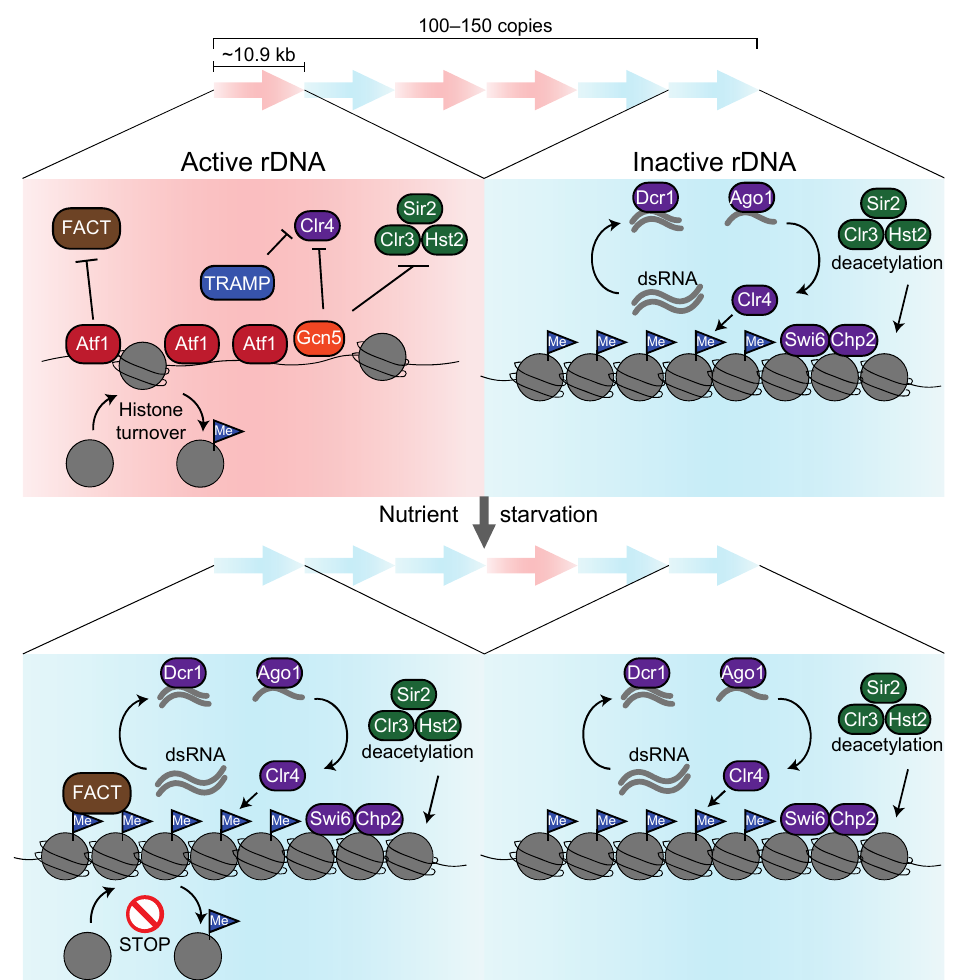
Figure 6. Regulatory mechanisms of rDNA gene expression in S. pombe . In nutrient-rich conditions (the pink area on the left), transcription factor Atf1 prevents the accumulation of histone chaperone FACT. Gcn5 HAT competes with histone deacetylase and methyltransferase to inhibit hypermethylation of H3K9. Without FACT, histone turnover is facilitated so that H3K9 methylation is quickly removed. TRAMP/exosome prevents the deposition of RNAi-related proteins in rDNA, preventing H3K9 methylation and heterochromatinization. Disruption of RNAi-related genes or deacetylase genes causes an enhancement in rRNA expression, suggesting that an RNAi-dependent pathway accelerates heterochromatin formation in dormant rDNA repeats. In nutrient starvation (the blue area on the right), Atf1 and Gcn5 dissociate from rDNA, leading to the recruitment of FACT. Methylated hi- stones are maintained by FACT, which prevents histone turnover. Removal of TRAMP/exosome from rDNA accelerates Ago1-dependent sRNA generation, resulting in the heterochromatin formation by RNAi-dependent